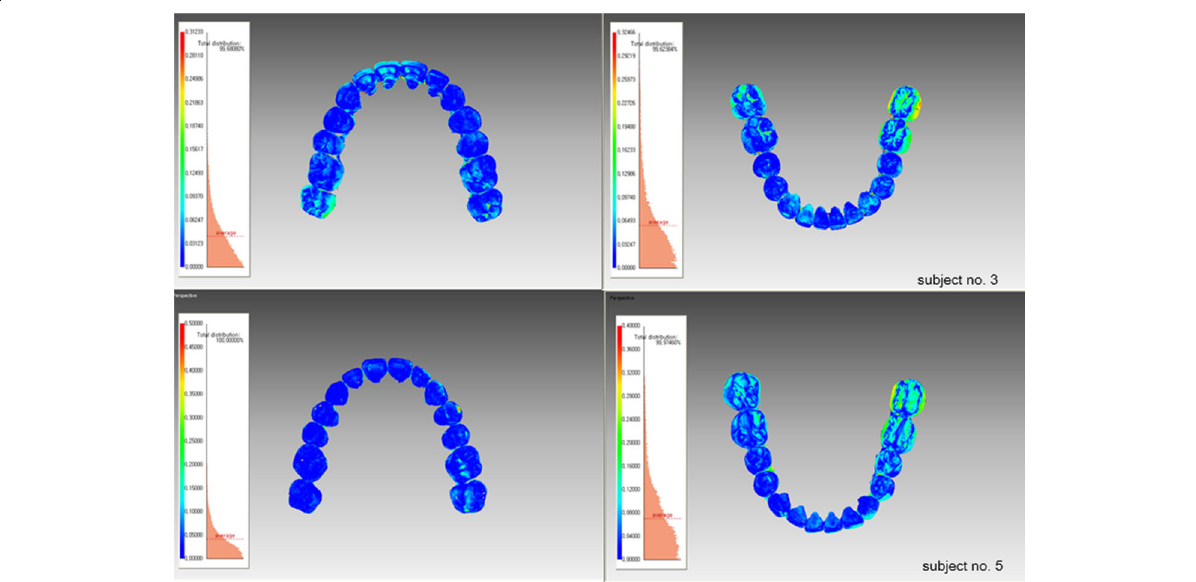
Fig. 3 Color-coded charts of the scanning results between the iTero and TRIOS scanners. The two images above are the scans of subject no. 3, and the two images below are the scans of subject no. 5. Discrepancies occurred in the posterior areas, particularly in the mandible on both